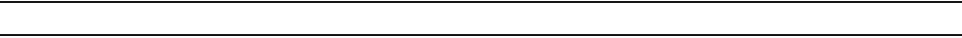
Table 4 Risk factors for MRONJ Risk factors Local risk